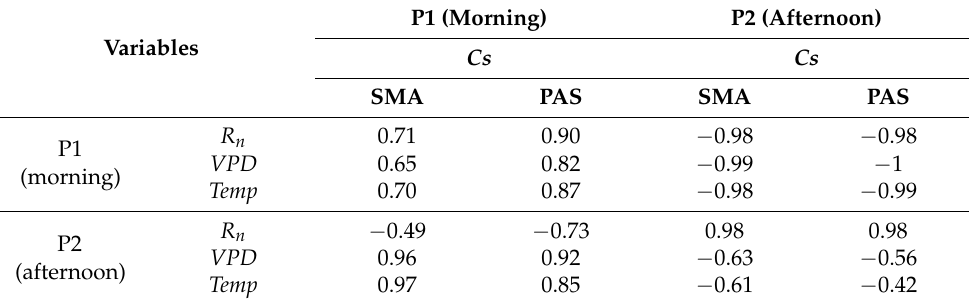
Table 5. Pearson correlation (r) between the surface conductance Cs (mm s − 1 ), and the net radiation ( Rn , W m − 2 ), air temperature ( Temp , ◦ C), and vapor pressure deficit ( VPD , kPa) for the Pampa biome, at the SMA and PAS sites in periods P1 (06 h 30 min–11 h 30 min) and P2 (12 h–17 h), with a p -value of